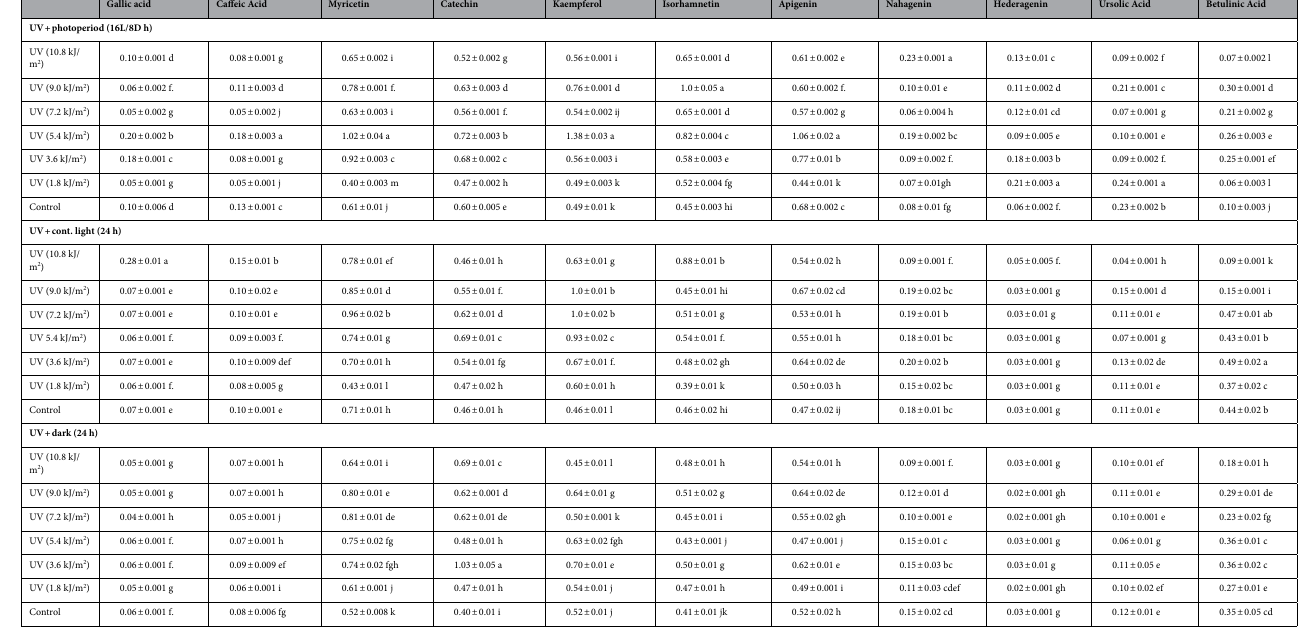
Table 1. HPLC based quantification of polyphenolic compounds in callus cultures of Fagonia indica elicited with UV-C doses (0–10.8 kJ/m 2 ) under different photoperiod regimes. Values are the mean of three triplicates ± standard error (SE). Different letters represent significant differences between the various experimental conditions ( p <